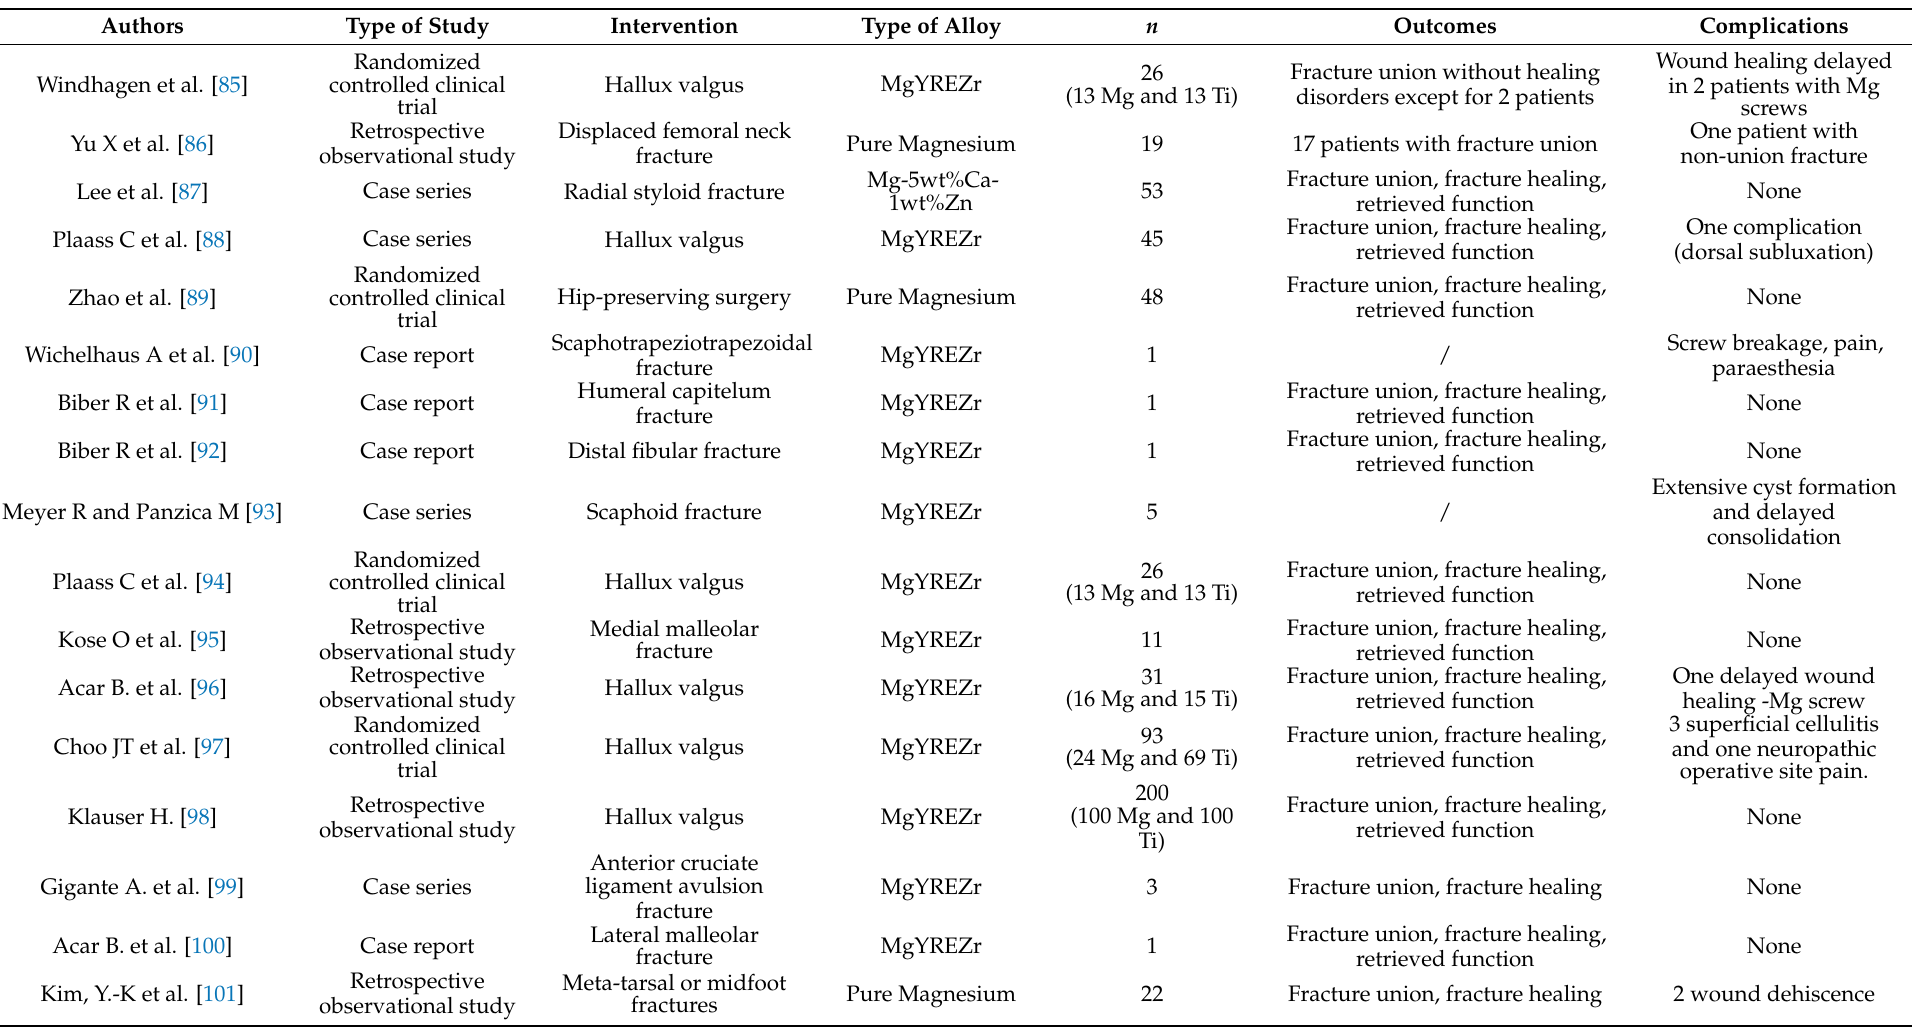
Table 2. Summary of the clinical studies using Mg-based implant in the field of orthopaedic surgery and